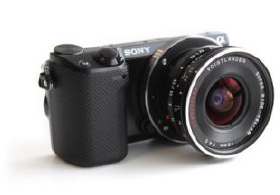
Figure 2. Sony NEX5R digital camera with Voigtlander 15 mm lens